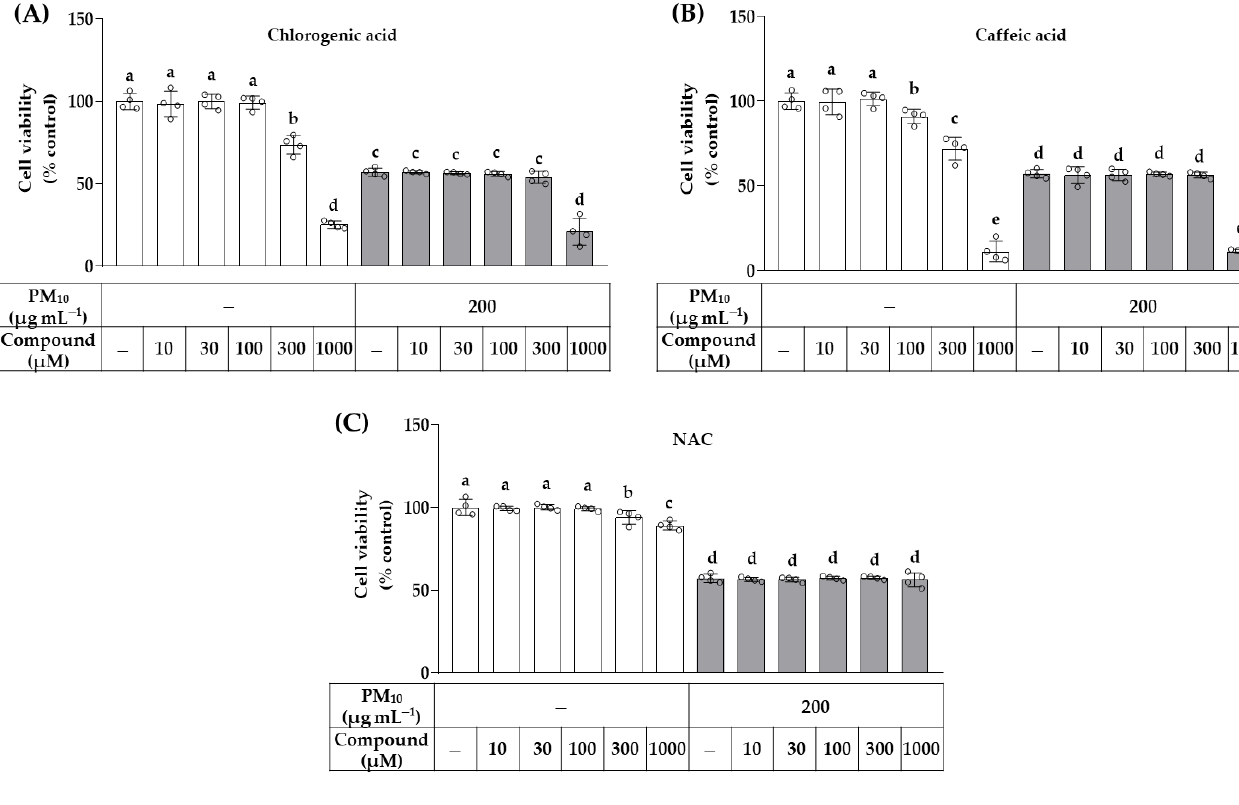
Figure 3. Effects of chlorogenic acid, caffeic acid, and N-acetyl cysteine (NAC) on the viability of HaCaT keratinocytes exposed to PM 10 . Cells were treated with chlorogenic acid ( A ), caffeic acid ( B ), or NAC ( C ) at the specified concentrations, alone or in combination with PM 10 (200 μg mL −1 ), for 48 h. Data are presented as mean ± SD ( n = 3). Groups that do not share the same lowercase alphabet letters (a–e) are considered to have significantly different means at the p < 0.05 level.